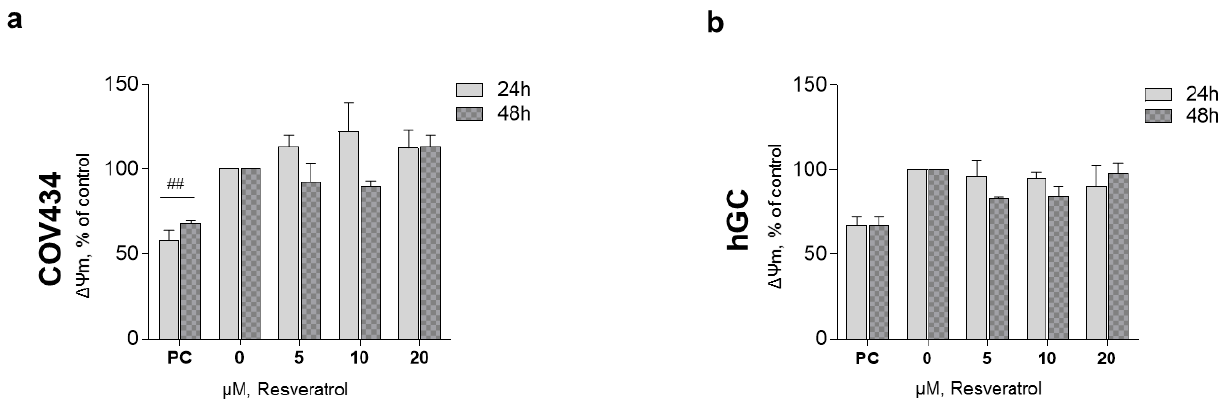
Figure 4. RES effect on granulosa cell (GC) mitochondrial membrane potential. ∆ ᴪ m of COV434 ( a ) and hGC ( b ) after 48 h of treatment with RES (5–20 µ M) compared with non-treated cells (control), assessed by fluorescence assay with DiOC 6 probe. Carbonyl cyanide m-chlorophenylhydrazone (CCCP) (10 µ M) was used as a positive control (PC). Results are related to the control and expressed as mean ± SEM of at least three independent experiments performed in triplicate. Significant differences between control and PC are indicated as ## ( p ˂ 0.01).